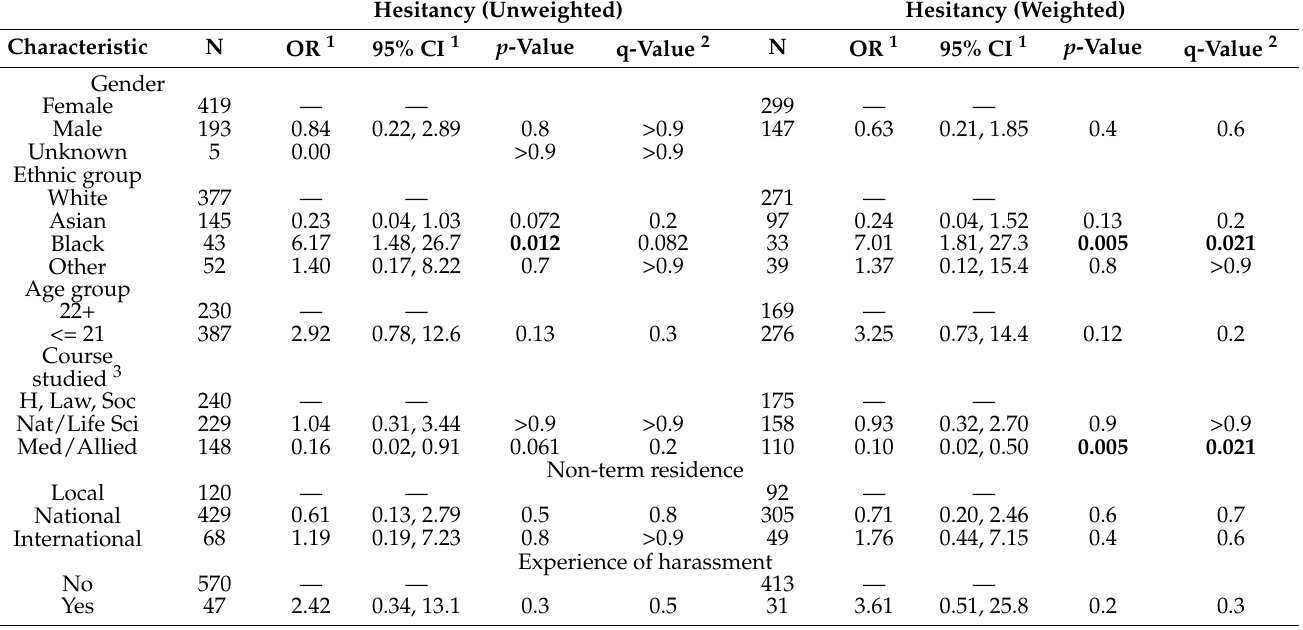
Table 2. Multivariate analysis of vaccine